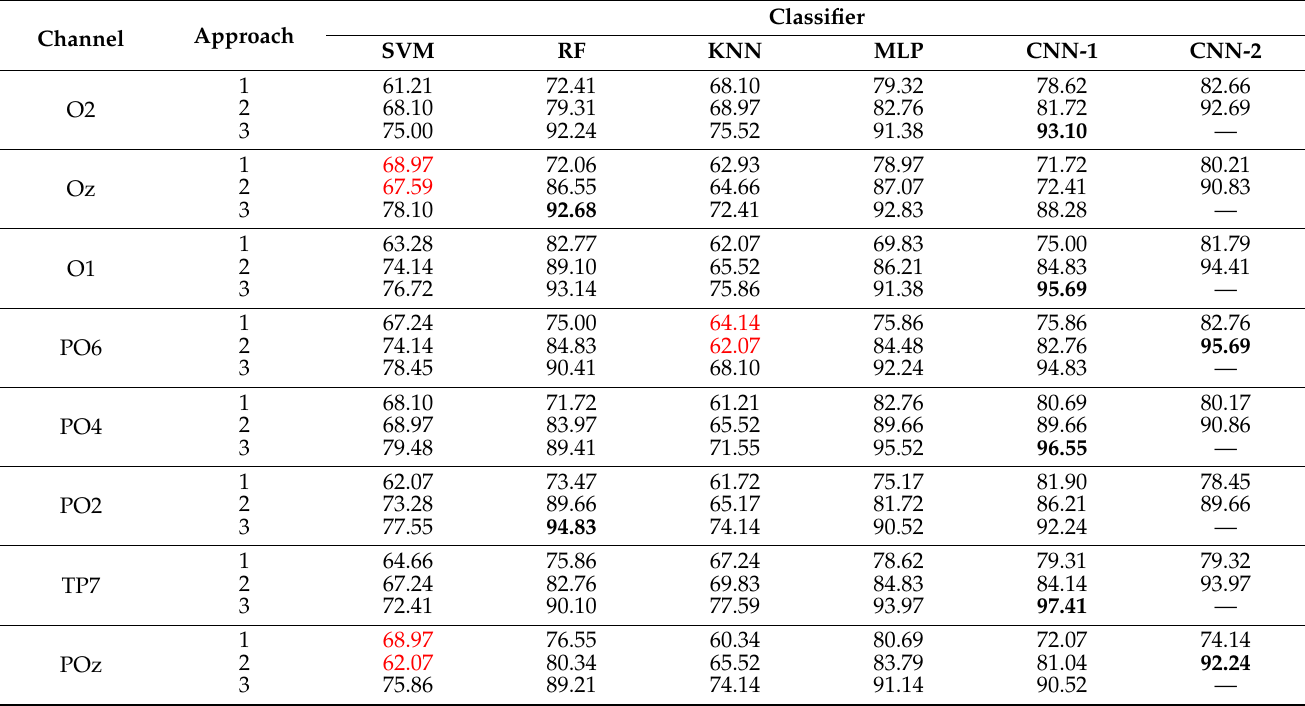
Table A3. Classification accuracies of the ERPs of Subject b 3 . Inconsistent results are highlighted in red. The best result for each channel is highlighted in bold font.